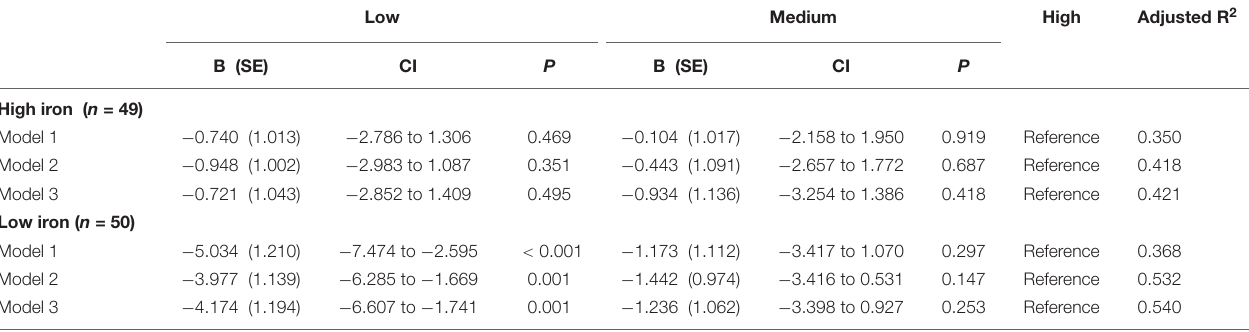
TABLE 10 | The results of multiple linear regression analyses assessing the associations between the serum copper strata and MMSE by iron subgroup.